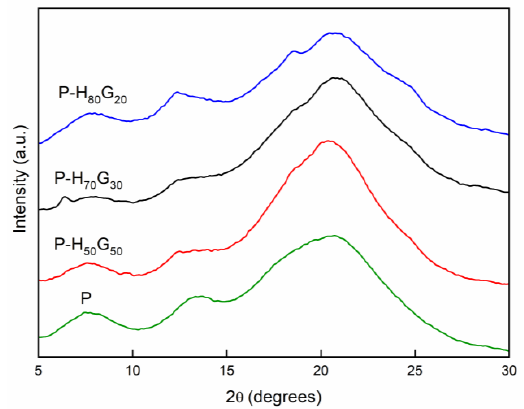
Figure 3. XRD pattern of pectin and pectin composites (P-H x G y ). ATR spectra were collected for all samples and are depicted in Figure 4.